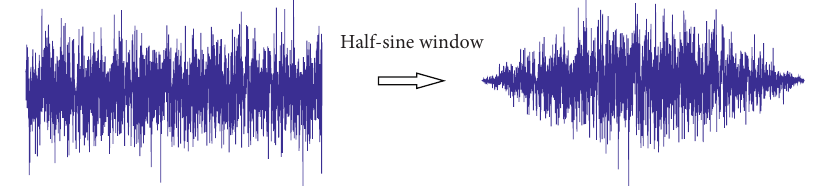
Figure 4: Schematic diagram of the windowing operation.